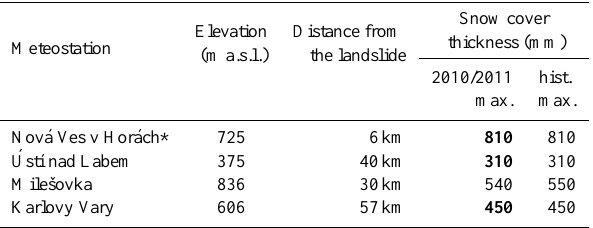
Table 1. A comparison of the maximum recorded snow cover thick- nesses at selected climatological stations with those recorded during the winter of 2010–2011 (Data source: Czech Hydrometeorological